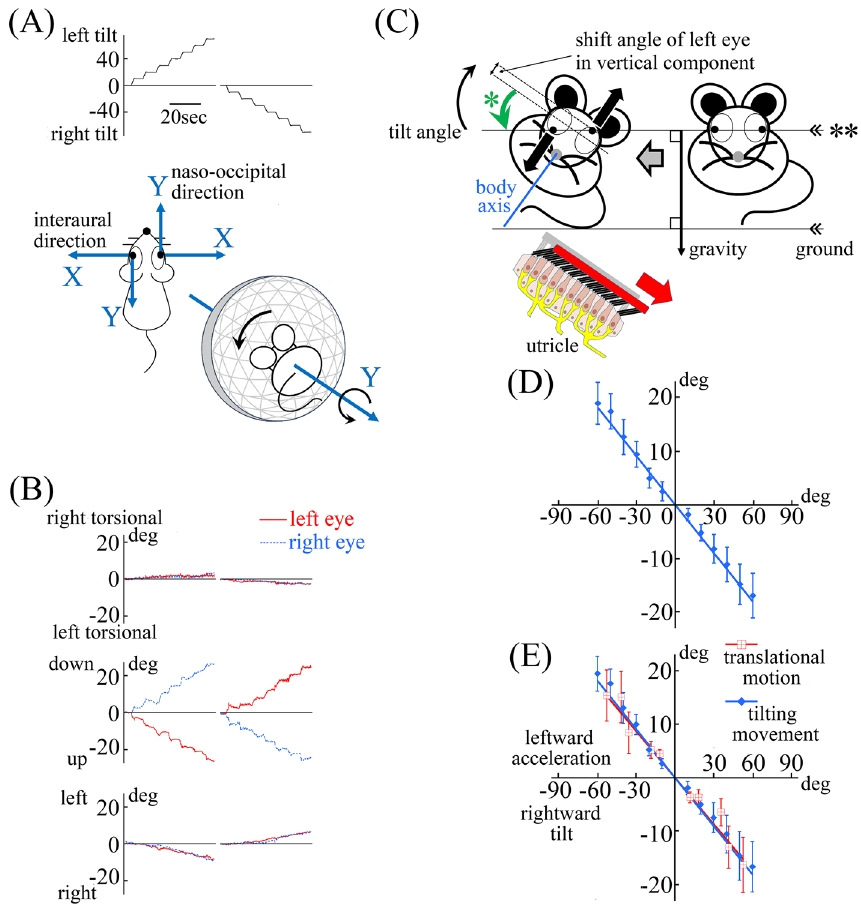
Figure 2. Mice exhibited an appropriate otolith ocular reflex to compensate for lateral tilting movement in dark conditions. ( A ) The tilt angle of the mouse. The mouse was first tilted leftward then tilted rightward. To prevent contamination of the semi-circular canal-ocular reflex, the mouse was tilted as slowly as possible, and remained still for approximately 5 s at each 10° interval. As shown in the inserts, when tilting laterally, the mouse rotates around the Y-axis, whereas the human rotates around the X-axis. Thus, the mouse’s eye movement compensates for the tilting movement with eye movement that rotates around the Y-axis, not around the X-axis. Therefore, the eye movement in the mouse is vertical eye movement, not torsional eye movement, as seen in humans. ( B ) Three-dimensional position data for both eyes of the mouse during lateral tilting movements in dark conditions that compensated for the tilting movements. These data show the three-dimensional positions of the movement of both eyes when tilting in dark conditions, as shown in ( A ). The eye movements were three-dimensionally described in the same way shown in Fig. 1B. As explained in ( A ), both eyes showed no torsional component (first column), but did show a vertical component. As expected from the eye movement results during translational motion (Fig. 1A,B), disconjugate vertical eye movement was observed (second column). When tilting leftward in dark conditions ( A ), both eyes rotated around the Y-axes, the left pupil moved upward, and the right pupil moved downward (second column). Both eyes rotated rightward slightly (third column). Therefore, the line passing through the centres of both pupils (the line indicated by ** in ( C )) tilts rightward. When tilting rightward, the line tilted leftward because the left pupil moved downward and the right pupil moved upward (second column). Both eyes rotated leftward slightly (third column). All mice showed the same disconjugate vertical eye movements. ( C ) Schema illustrating the mouse’s disconjugate vertical eye movement corresponding to torsion in humans, induced when tilting leftward. The line passing through the centres of both pupils (the line shown by **) is tilted rightward (green curved arrow shown by *). As a result, the line is kept stable in space and almost parallel to the ground by compensating the tilt angle of the mouse. The rotation of the line appears to be similar to torsion in humans. Therefore, the mouse’s disconjugate vertical eye movement appears to correspond to torsion in humans. This disconjugate vertical eye movement is referred to as torsion-like eye movement hereafter. ** straight line passing through the centres of both pupils. * disconjugate vertical eye movement corresponding to torsion in humans. ( D ) The line created using population-based outcomes of the vertical shift angle data during lateral tilting in dark conditions. In the graph, the average shift angle of the vertical component of both eyes of all mice during the lateral tilting movement ( C ) was set on the ordinate axis, and the tilting angles ( C ) were set on the abscissa axis. The shift angle of the vertical component of both eyes was calculated using the formula: ((shift angle of vertical component of the left eye) − (maximum shift angle of vertical component of the right eye))/2. The shift angle during leftward tilt was plotted on the positive side of the abscissa axis. The shift angle during rightward tilt was plotted on the negative side of the abscissa axis. The error bar shows the 95% confidence interval. Population- based outcomes, for all mice, of the averaged shift angle of the vertical component during lateral tilting movement in darkness were proportional to the tilting angle of mice. ( E ) This graph was constructed by overlaying the graphs shown in Fig. 1E and ( D ). To overlay the graphs, the abscissa axis in Fig. 1E was changed from linear acceleration to tilt angle of GIA (see Fig. 1F legend for the method of calculation of tilt angle of GIA from linear acceleration). The data during translational motion (red line) and the data during tilting movement (blue line) were plotted on the same straight line. This result indicates that during both lateral translational motion and lateral tilting movement, the same otolith-ocular reflex (torsion-like eye movement) was